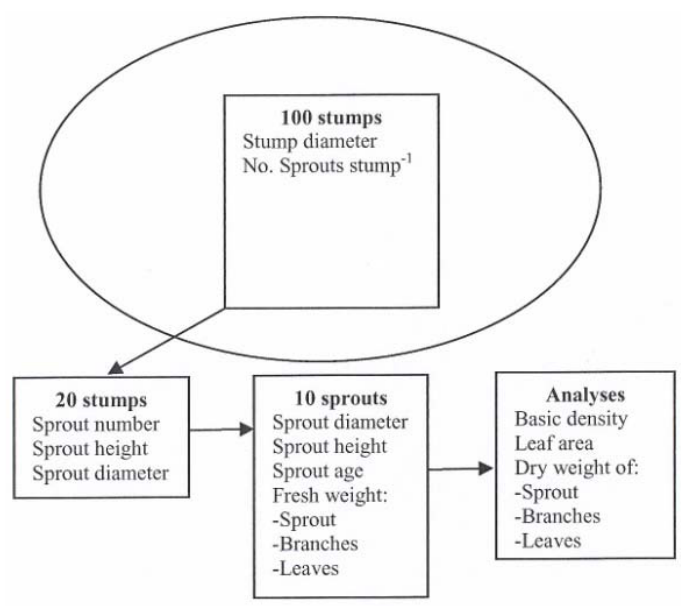
Figure 2. Sampling of sprouts.